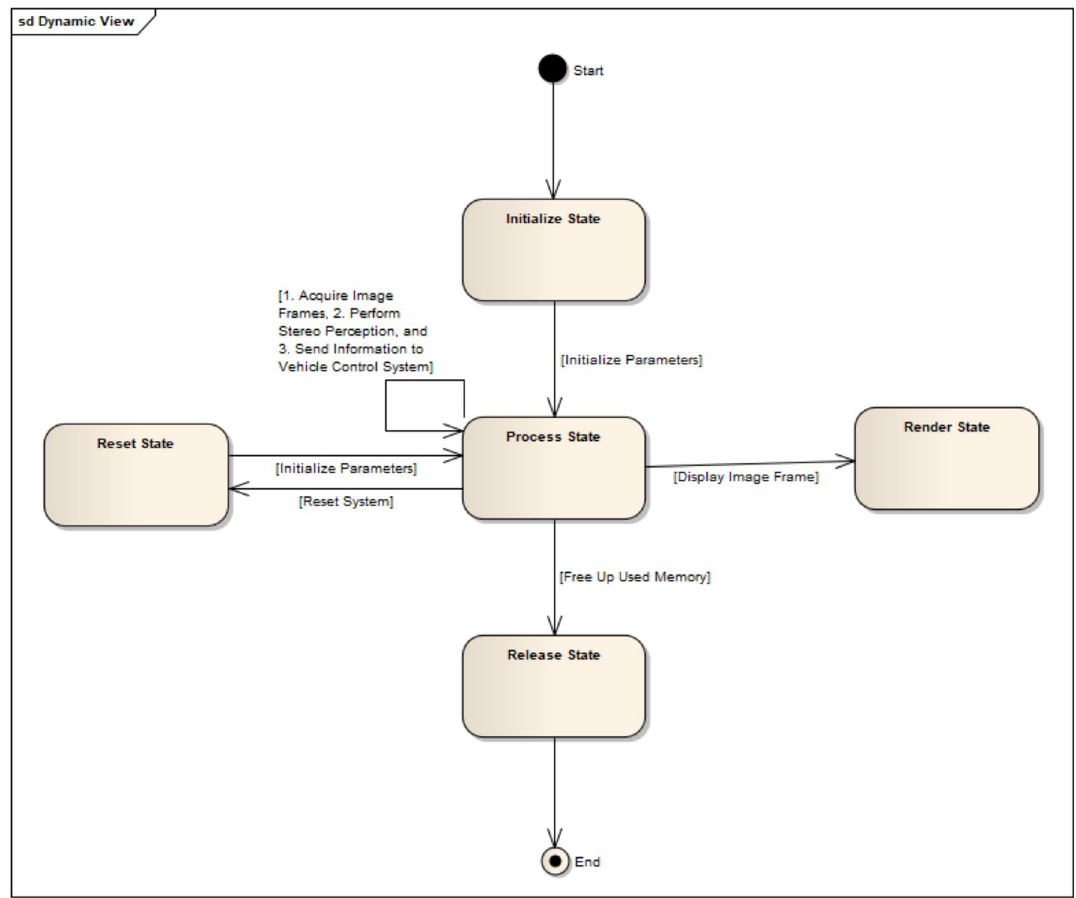
Fig. 9 State diagram of the stereo vision